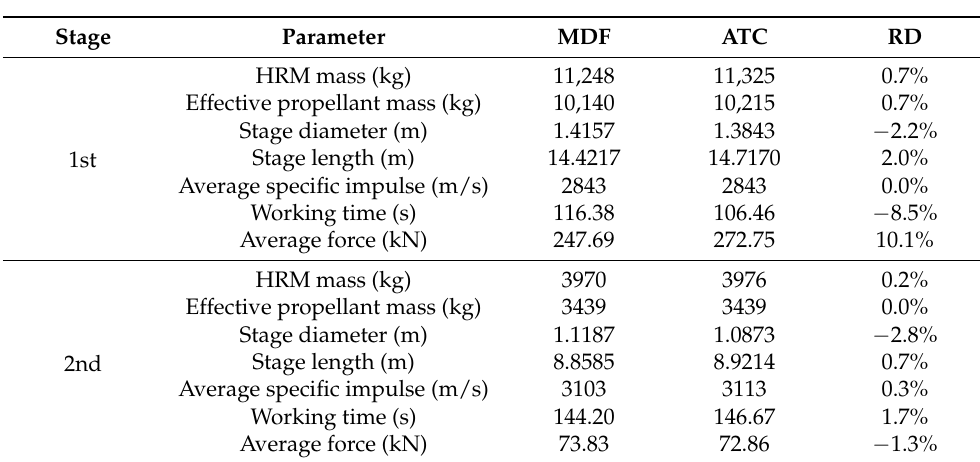
Table 7. HRM performance at each